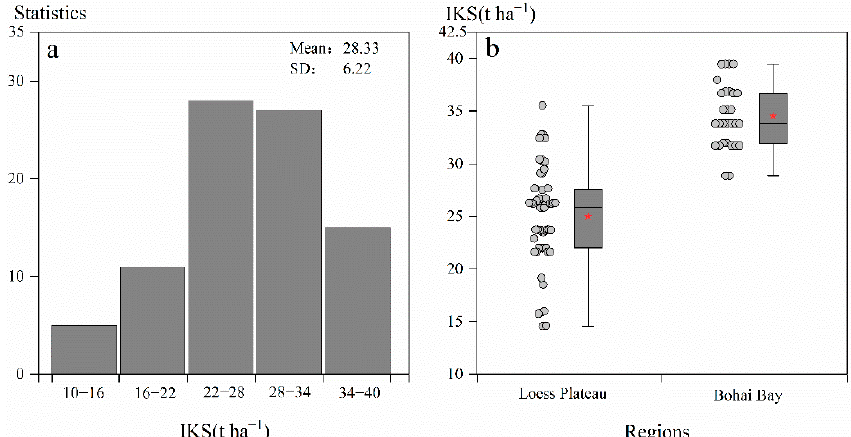
Figure 3. Statistics of soil indigenous K supply (IKS) from apple production areas in Loess Plateau and Bohai Bay of China ( a ) and comparison of IKS between these two areas ( b ). Mean, average IKS of the entire study area; SD, standard deviation. ★ represents the average IKS at regional scale.